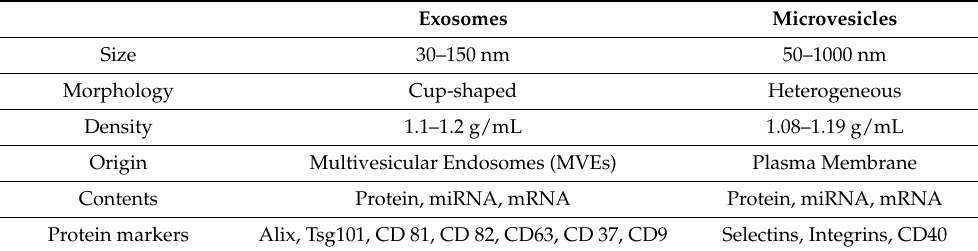
Table 1. Key difference between exosomes and